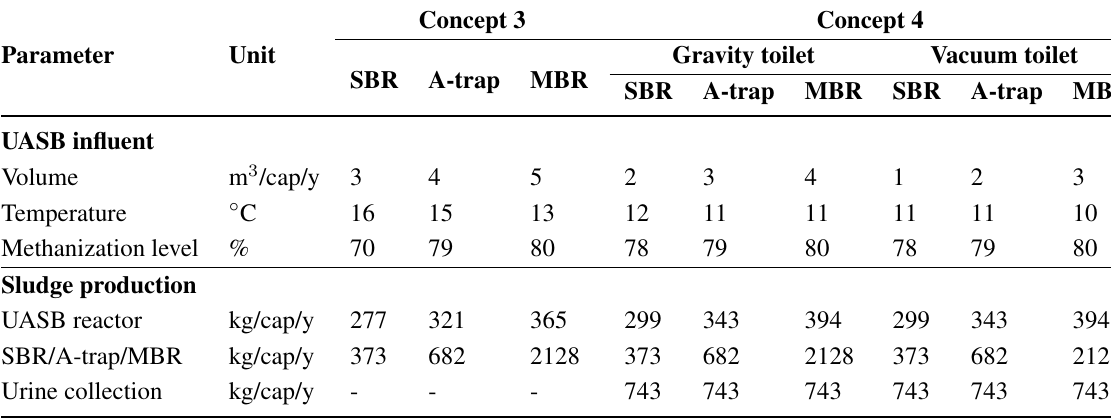
Table A2. UASB influent characteristics, sludge production and urine collection in Concepts 3 and 4 with different grey water treatment configurations (without co-digestion using the SBR or with co-digestion using the A-trap/MBR) (UASB = up-flow anaerobic sludge blanket reactor, OLAND = oxygen limited anaerobic nitrification A-trap = A-stage of AB-process and MBR = membrane